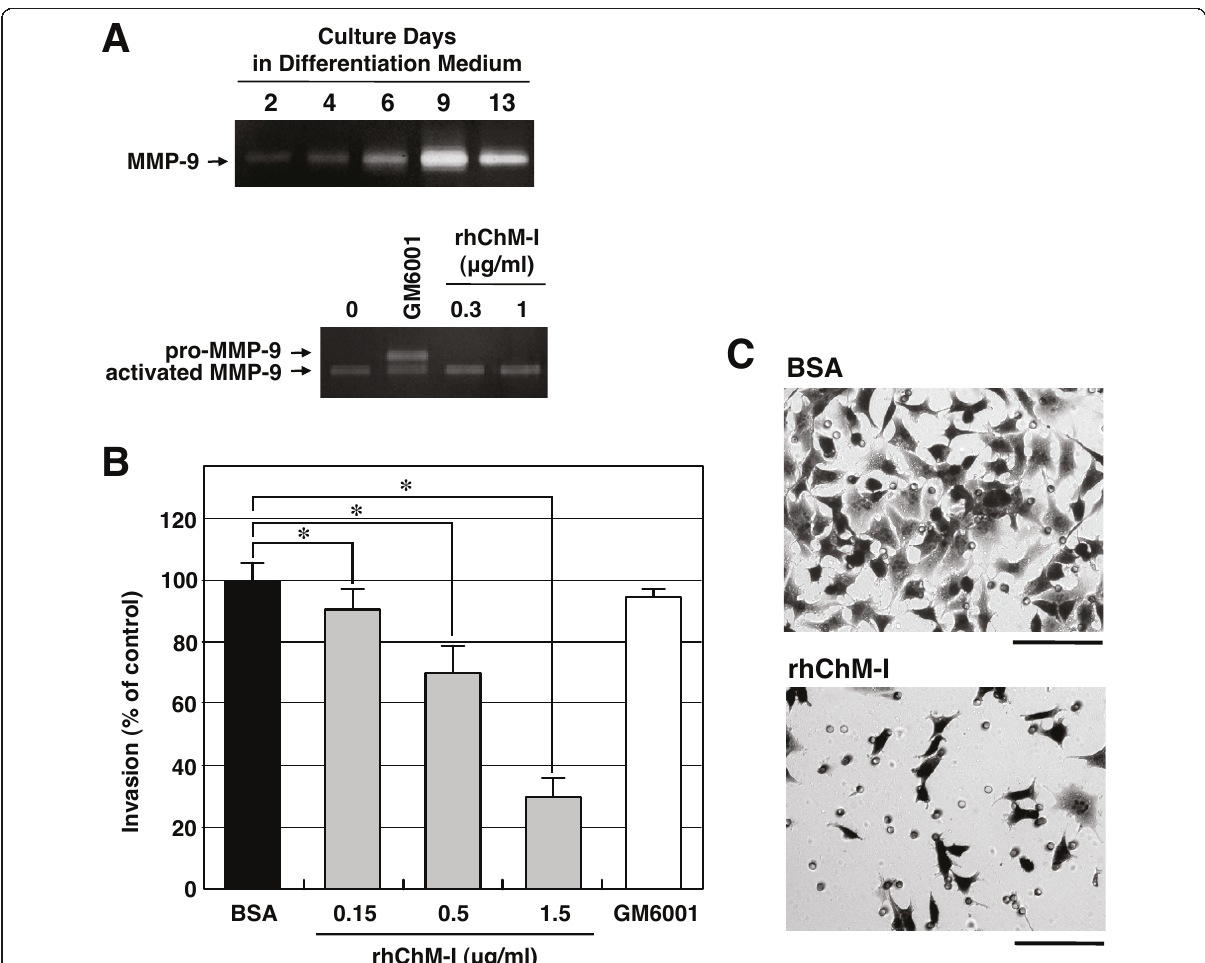
Figure 8 Effects of rhChM-I on the invasion of Rcho-1 trophoblast cells . (A) Effects of rhChM-I on the production and activation of MMP-9 in cultures of Rcho-1 trophoblast cells. Cells were grown to confluence, and the culture medium was then replaced with differentiation medium (NCTC-135 medium containing 10% horse serum). At the indicated time points (at day 2, 4, 6, 9, and 13), the culture medium was changed to medium containing 1% horse serum and conditioned for 24 h. The gelatinolytic activity in the conditioned medium was analyzed by gelatin zymography (upper panel). rhChM-I or GM6001 (25 μ M) was added to cultures of Rcho-1 trophoblast cells in differentiation medium on day 9, and the cells were incubated another for 24 h in medium containing 1% horse serum. The gelatinolytic activity in the conditioned medium